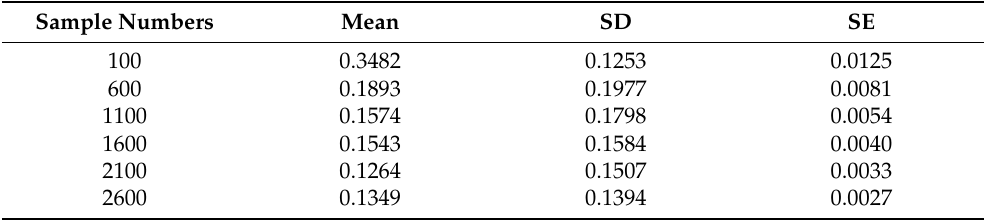
Figure 11. The standard error diagram of the MSE. Table 6. Results of error